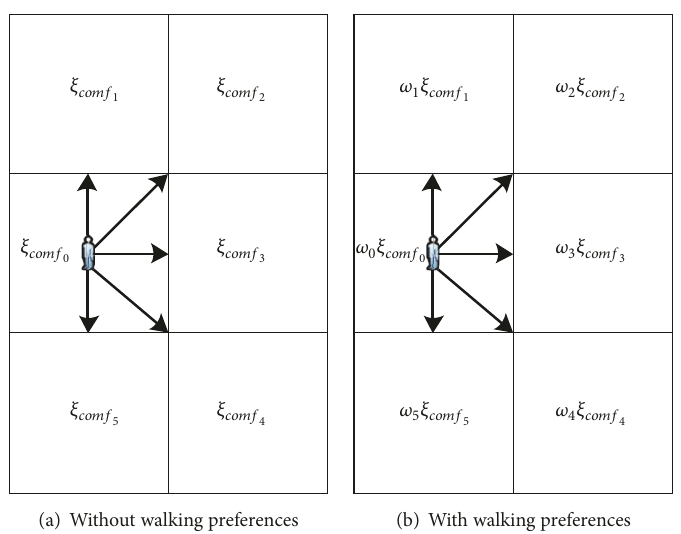
Figure 13: Expected comfort utilities for pedestrian choices with/without walking preferences.